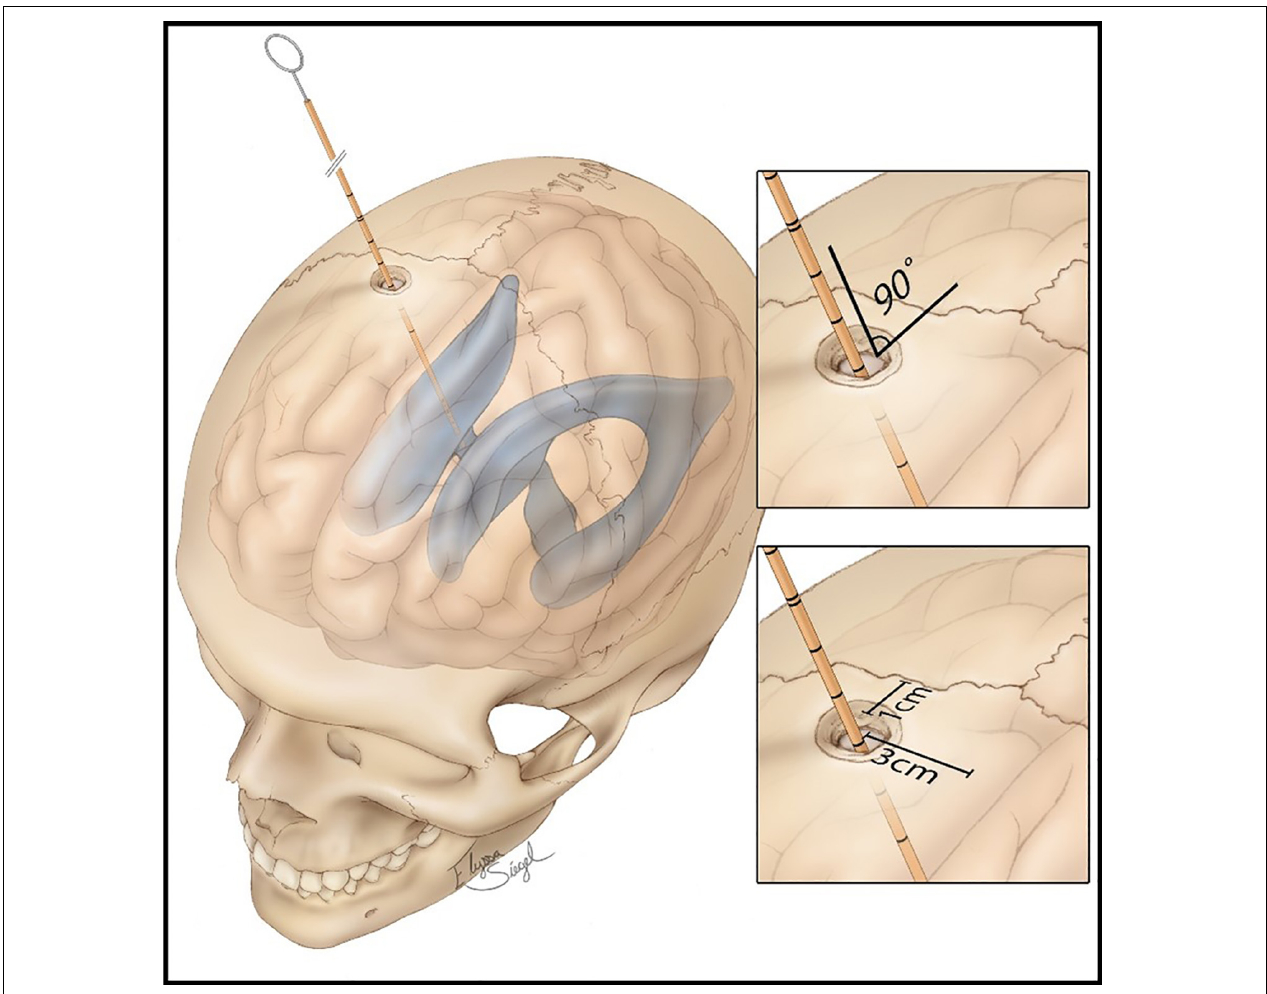
FIGURE 1 | Standard procedure of external ventricular drain (EVD) placement, showing the distances from the coronal suture, midline, and the angle of 90 ◦ of the catheter, aiming to perpendicularity. Source: https://assets.neurosurgicalatlas.com/volumes/ATLAS/1-PRINCIPLES_OF_CRANIAL_SURGERY/16-External_ Ventricular_Drain/PCS_ExtIntraventDrain_03.jpg (last accessed: March 30,